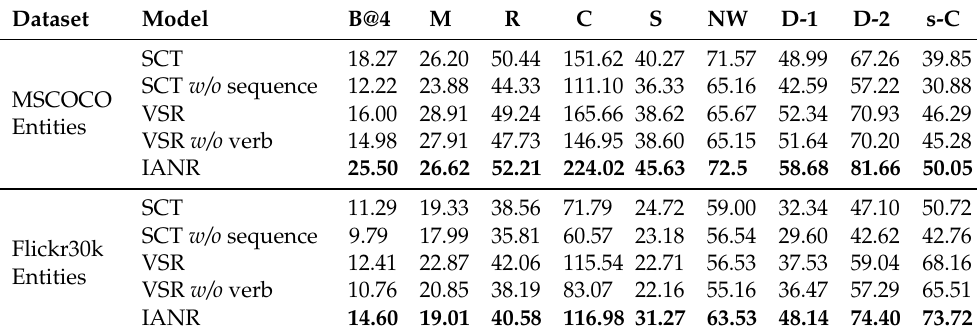
Table 4. The performance comparisons on MSCOCO Entities and Flickr30k Entities datasets. All tests were performed in the common part of the datasets, but each model had region features. Bold for the best.